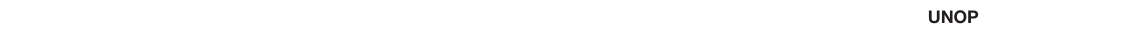
TABLE 4 | Nursing con fi dence inspired by PEWS. SJCRH